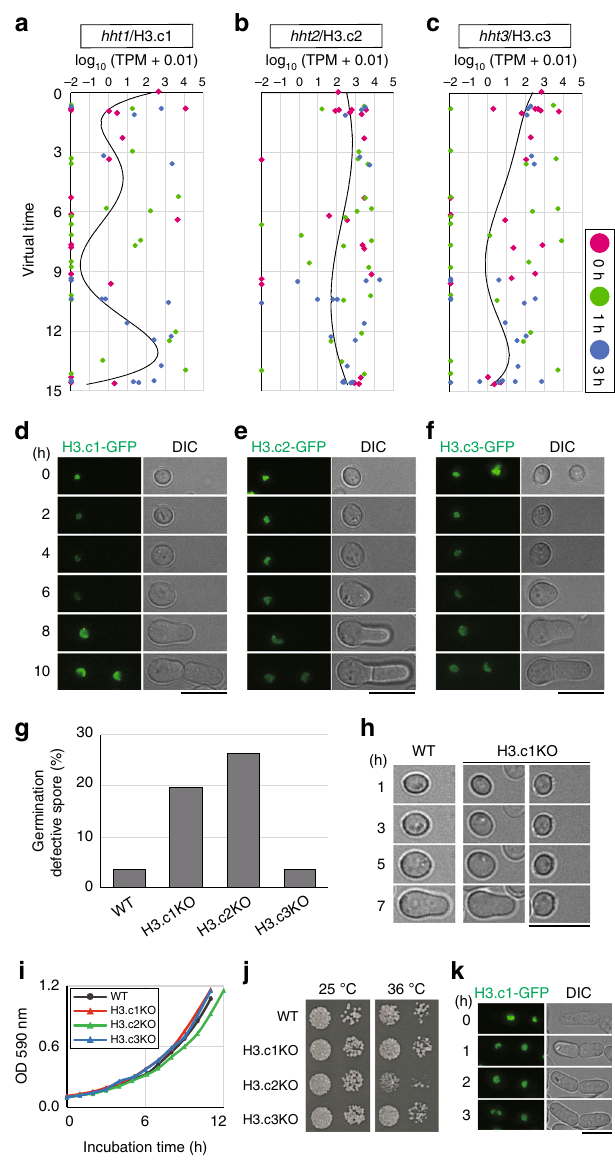
represents sense transcripts, as antisense transcripts of the H3.c1 gene was ~1% of sense transcripts 16 .